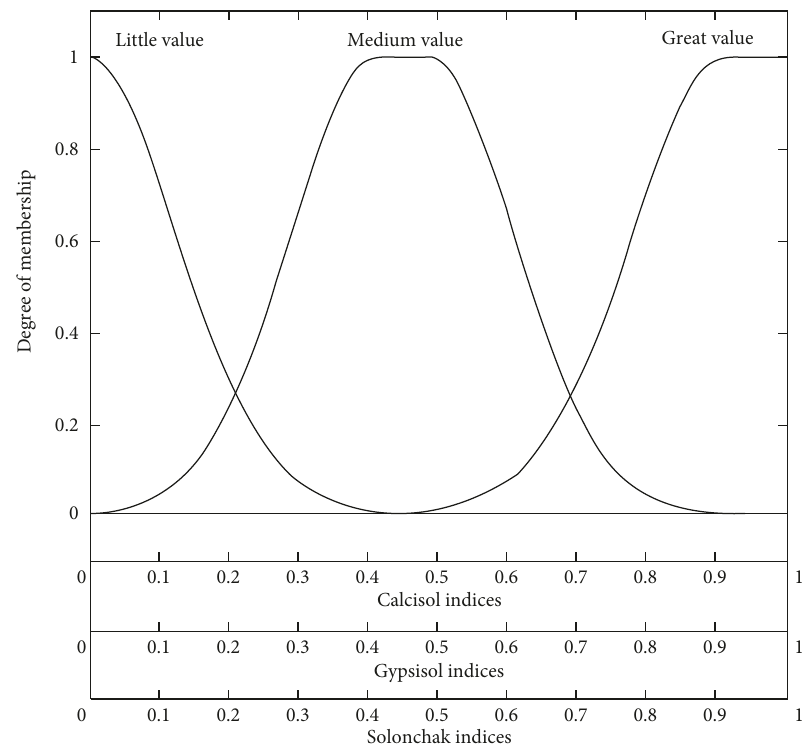
Figure 4: Membership function of the output variables.